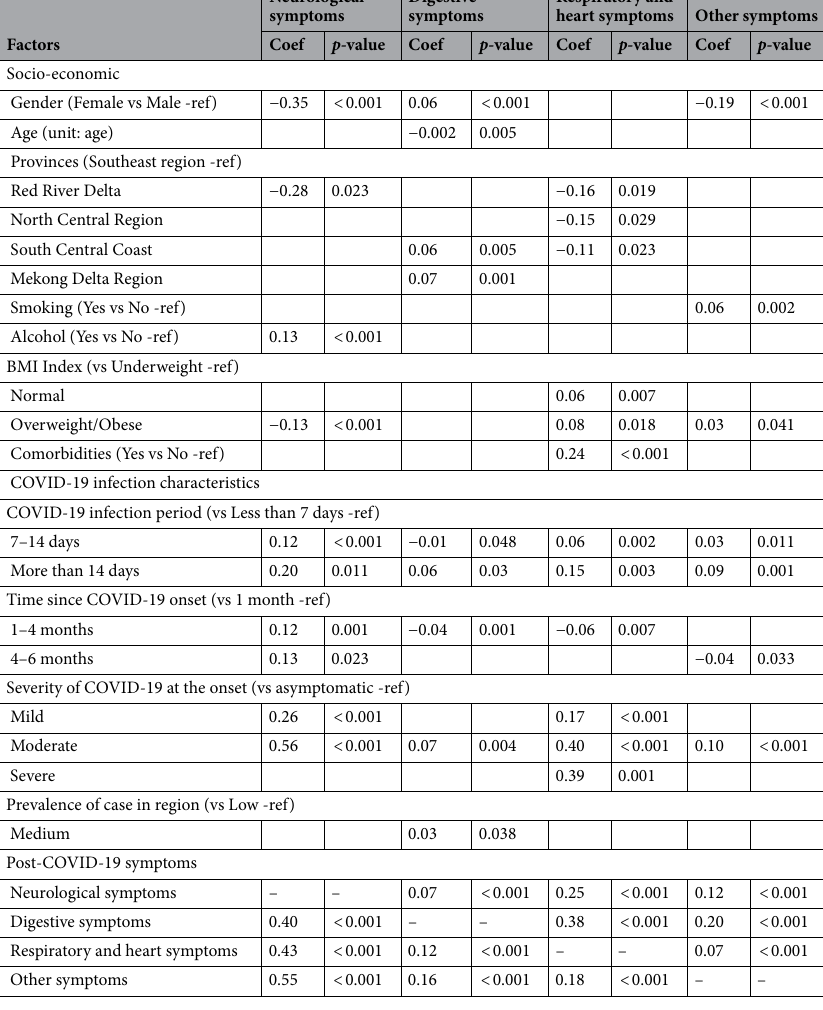
Table 4. Brief Multilevel linear random-effects models to identify factors associated with neurological, digestive, respiratory, heart, and other